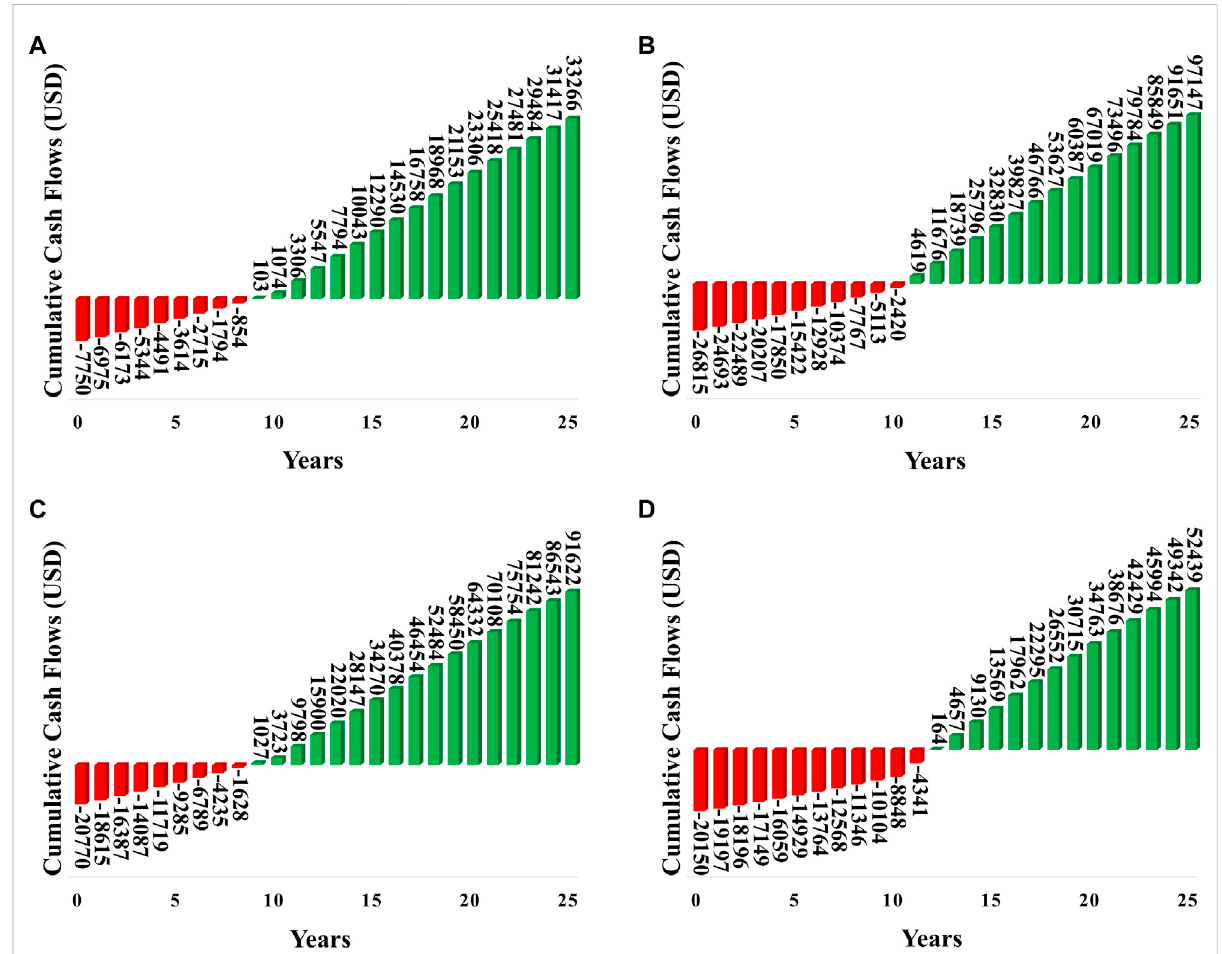
FIGURE 13 Cumulative cash fl ow for PV projects (A) Multan. (B) Lahore. (C) Sargodha. (D)